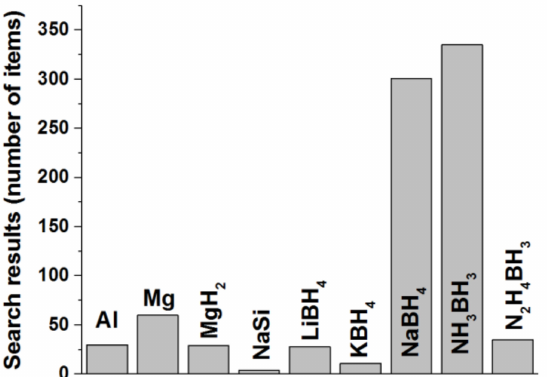
Figure 1. Number of results for a bibliometric resource search made on the Web of Science website (December 2020). The search combination was “compound” AND “hydrogen storage material” AND “hydrolysis”. An exception was made for sodium silicide. In this case, the search combination was “compound” AND “hydrogen